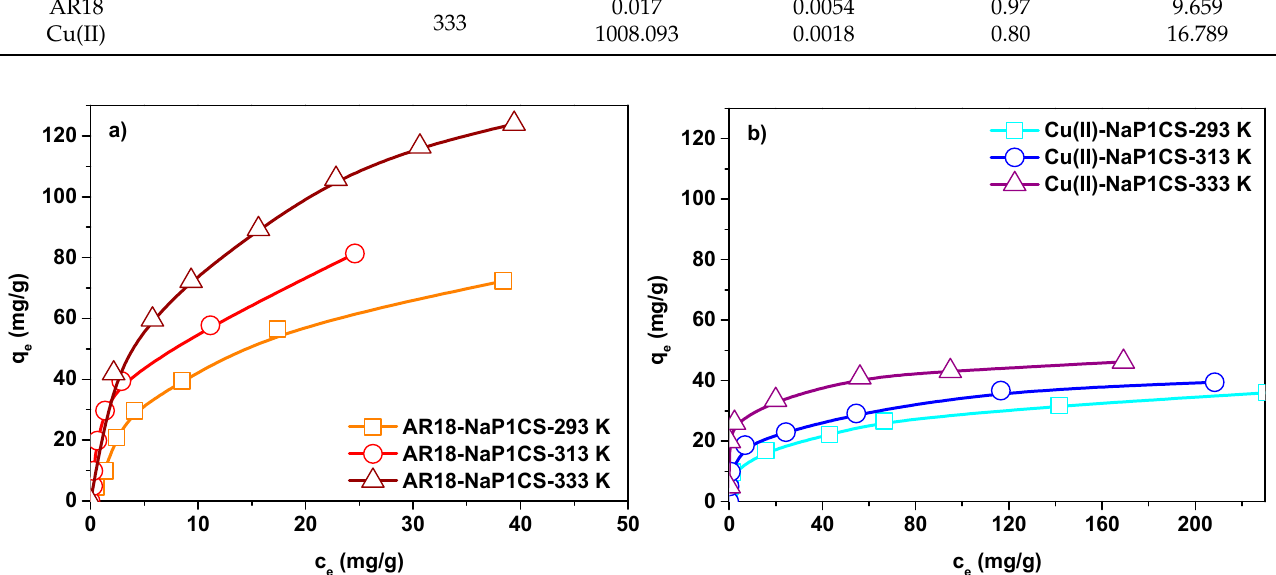
Figure 7. Effect of temperature on the adsorption isotherms of ( a ) AR18 and ( b ) Cu(II) adsorption on NaP1CS (m = 0.1 g, t = 120 min., co = 10–400 mg/L, A = 7, 180 rpm, pH = 6).